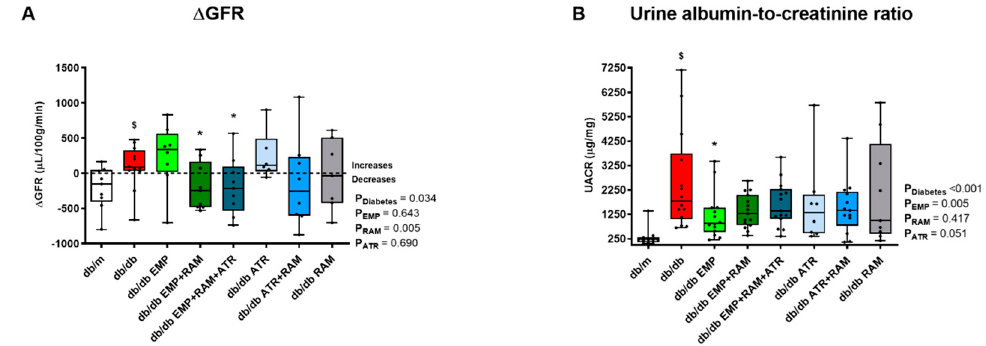
Figure 2. Glomerular filtration rate difference ( ∆ GFR) from baseline and urinary albumin-to- creatinine ratio (UACR) at the end of the experiment in vehicle-treated db/m mice, vehicle-treated db/db mice, and db/db mice treated with empagliflozin, atrasentan, ramipril, or their